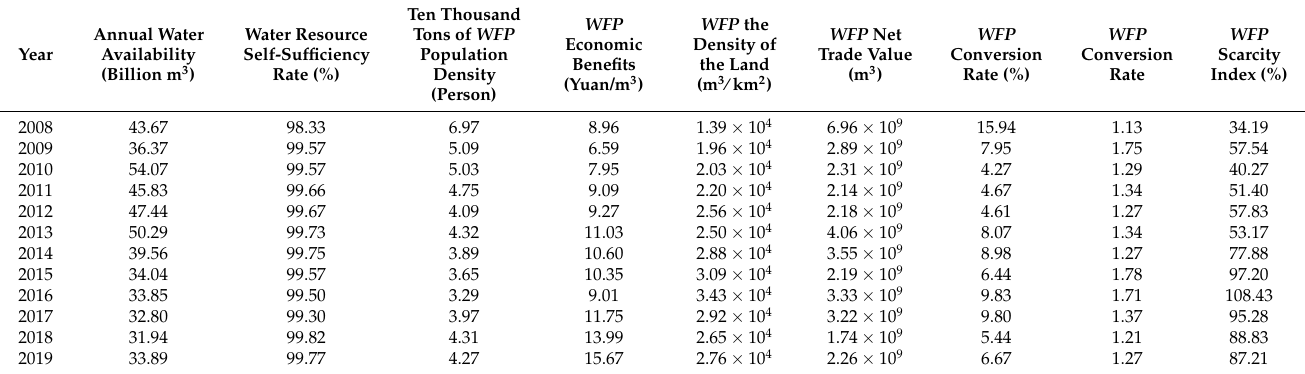
Table 6. Evaluation index system of water footprint in Tarim River